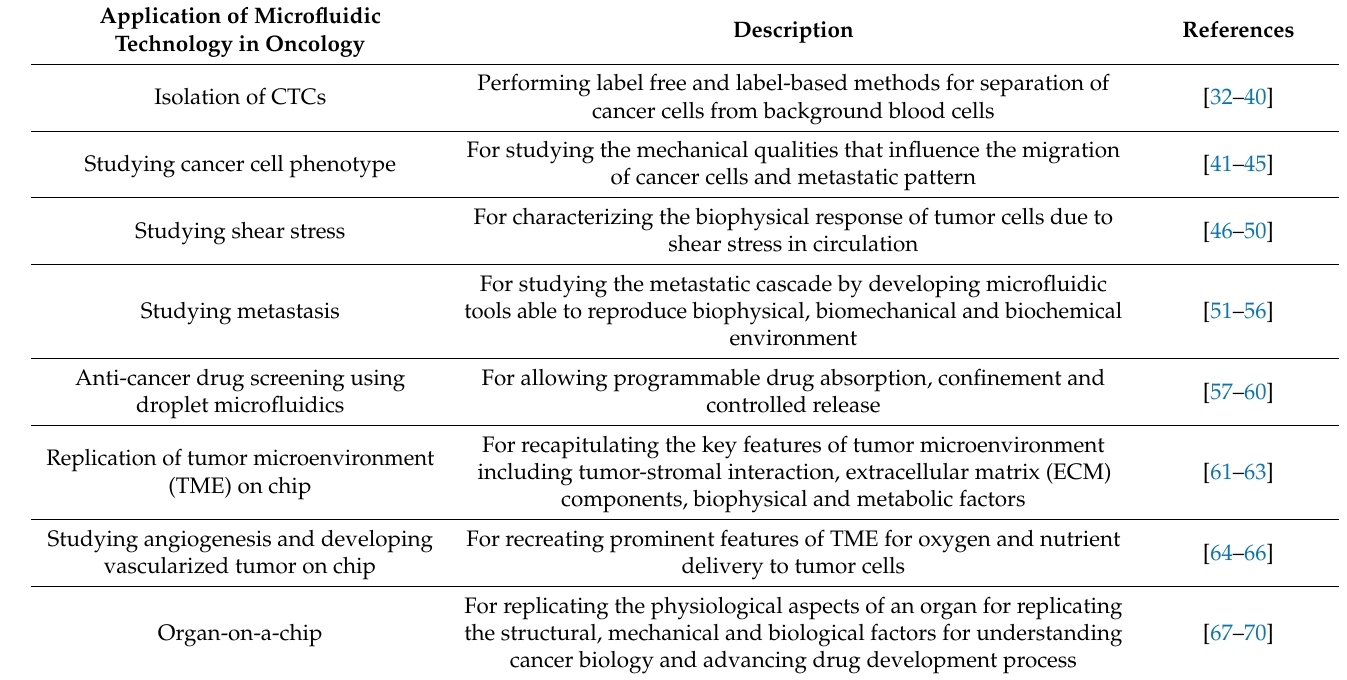
Table 1. An overview of microfluidic tools used in cancer